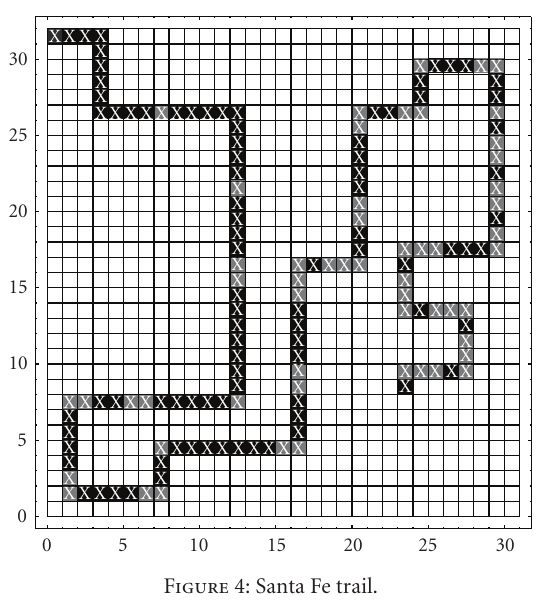
Figure 4: Santa Fe